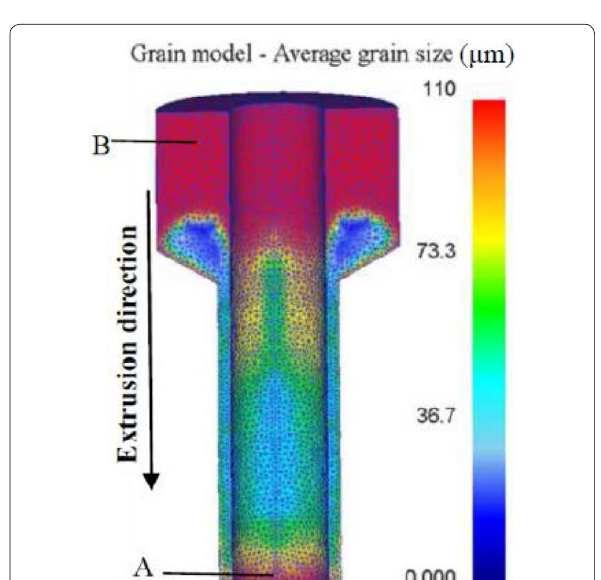
Figure 11 Grain sizes of the extrude pipe during hot extrusion